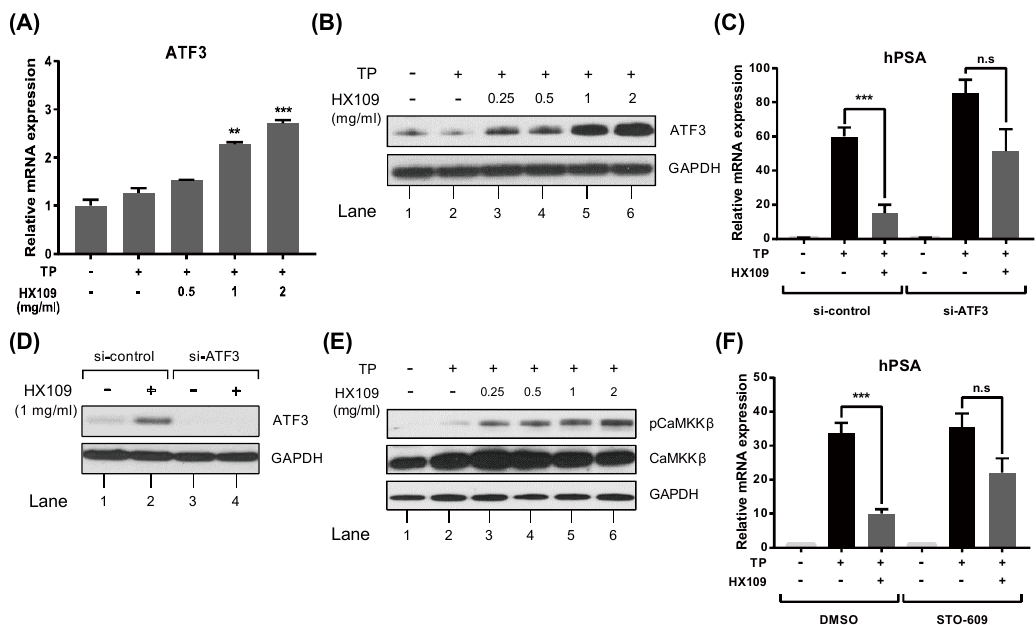
Figure 6. HX109 regulated AR transcriptional activity by phosphorylation of CAMKK β and upregulation of ATF3. LNCaP cells were treated as described in Figure 3, and total RNAs and proteins were prepared and analyzed for ATF3 by quantitative RT-PCR and western blot, respectively. Effects of HX109 on ATF3 RNA ( A ) and protein ( B ) levels were measured after a 6 h or 8 h treatment with HX109, respectively. ** p < 0.01, *** p < 0.001 (one-way ANOVA) compared with TP only. LNCaP cells were transfected with ATF3 siRNA or control siRNA for 24 h and then treated with 100 nM TP in the presence of HX109 1 mg/mL. ( C ) The expression of hPSA RNA levels were measured by quantitative RT-PCR after 24 h treatment. *** p < 0.001. ( D ) The protein levels of ATF3 were determined by western blot after 8 h treatment. ( E ) Effects of HX109 on the phosphorylation of CAMKK β were measured by western blot. Total proteins were prepared after 30 min of TP and HX109 treatment. ( F ) LNCaP cells were incubated with 30 µ M STO-609 for 30 min and treated with 100 nM TP in the presence of 1 mg/mL HX109 for 24 h. The RNA levels of hPSA were measured by quantitative RT-PCR. Values of qRT-PCR were normalized to GAPDH. *** p < 0.001 (one-way ANOVA) compared with TP only. n.s, not significant. For western blot, three independent experiments were performed, and one representative result is shown